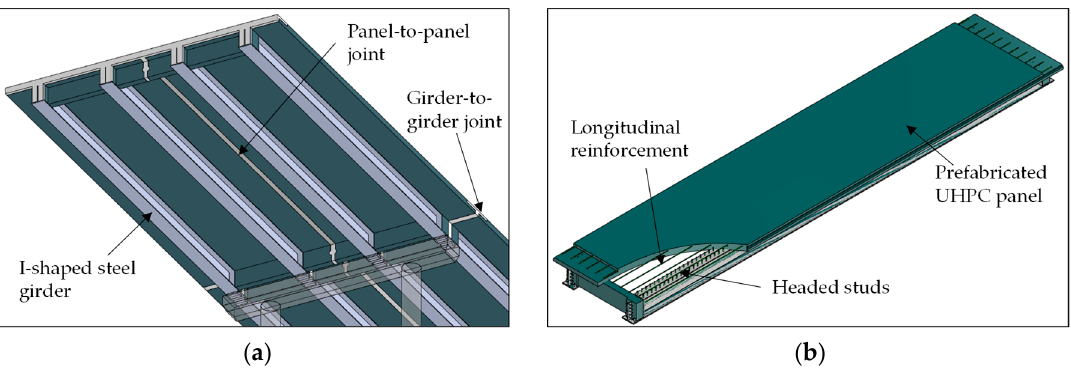
Figure 1. View of the lightweight steel-ultra-high-performance concrete (UHPC) composite bridge (LWCB): ( a ) the whole bridge; ( b ) prefabricated component. (LWCB): ( a ) the whole bridge; ( b ) prefabricated